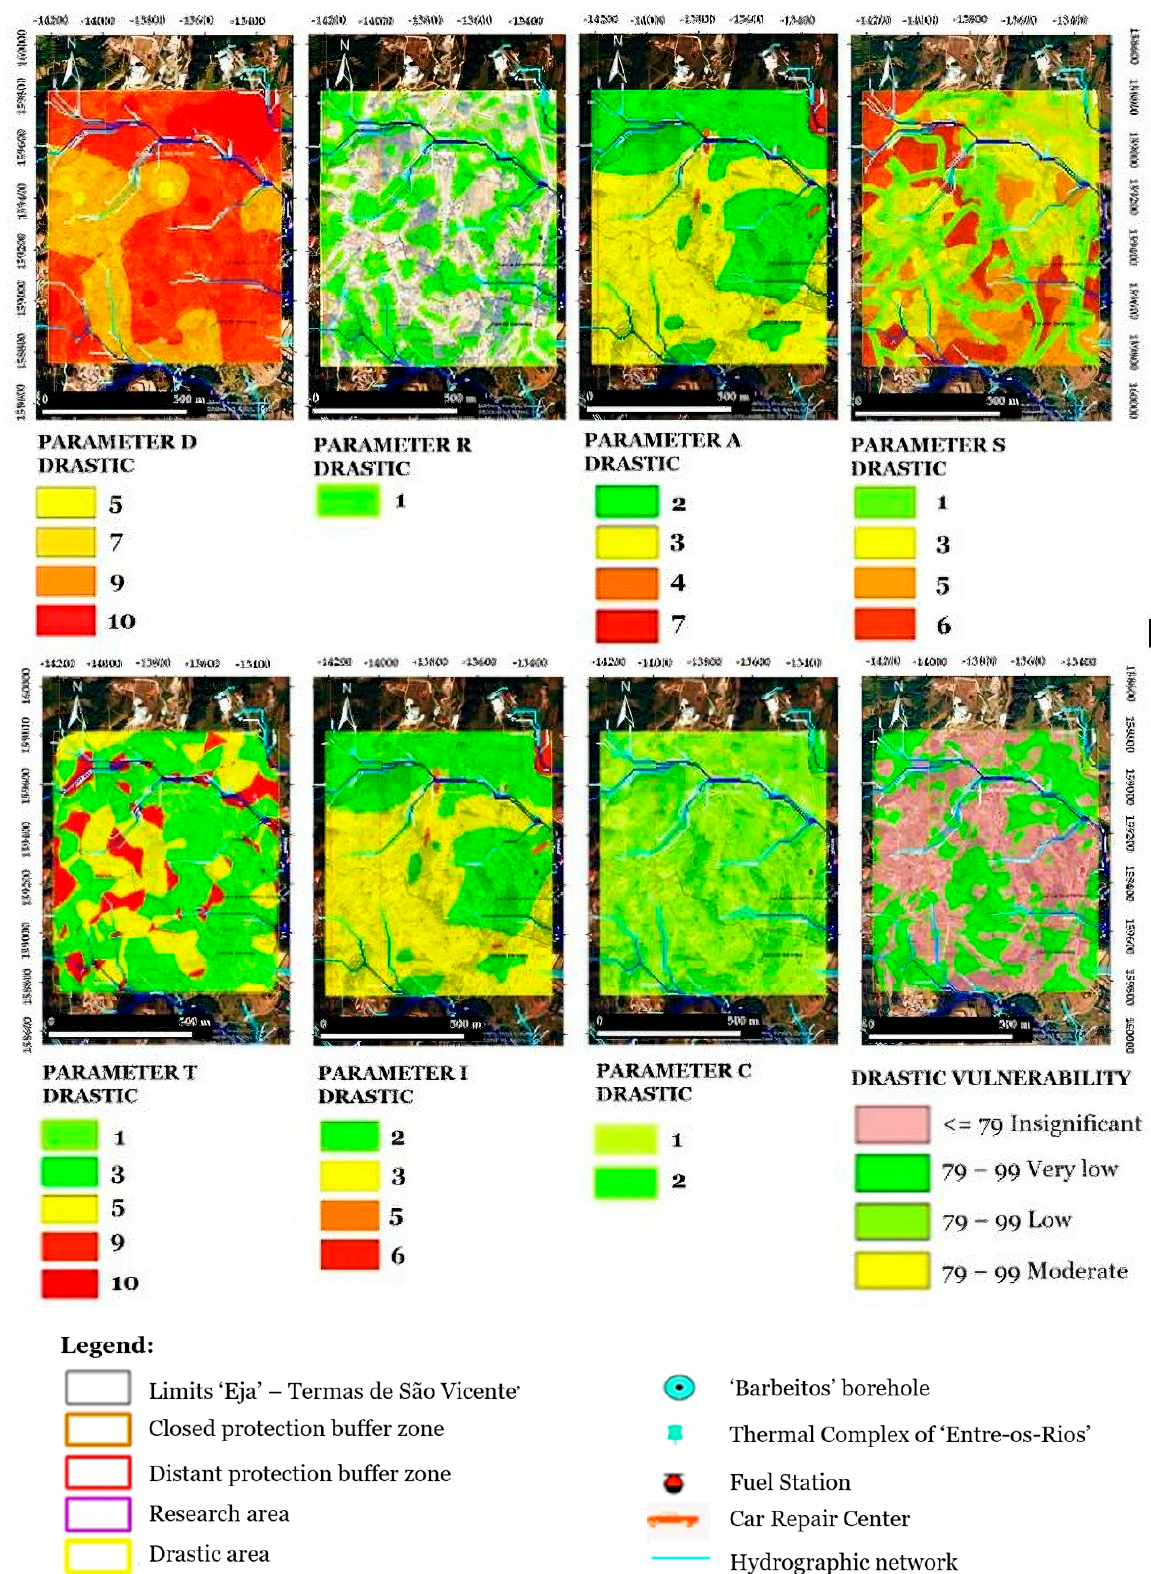
Figure 12. Map of parameters (D, R, A, S, T, I, C) and map of vulnerability to pollution of the ‘Entre-os-Rios’ aquifer.